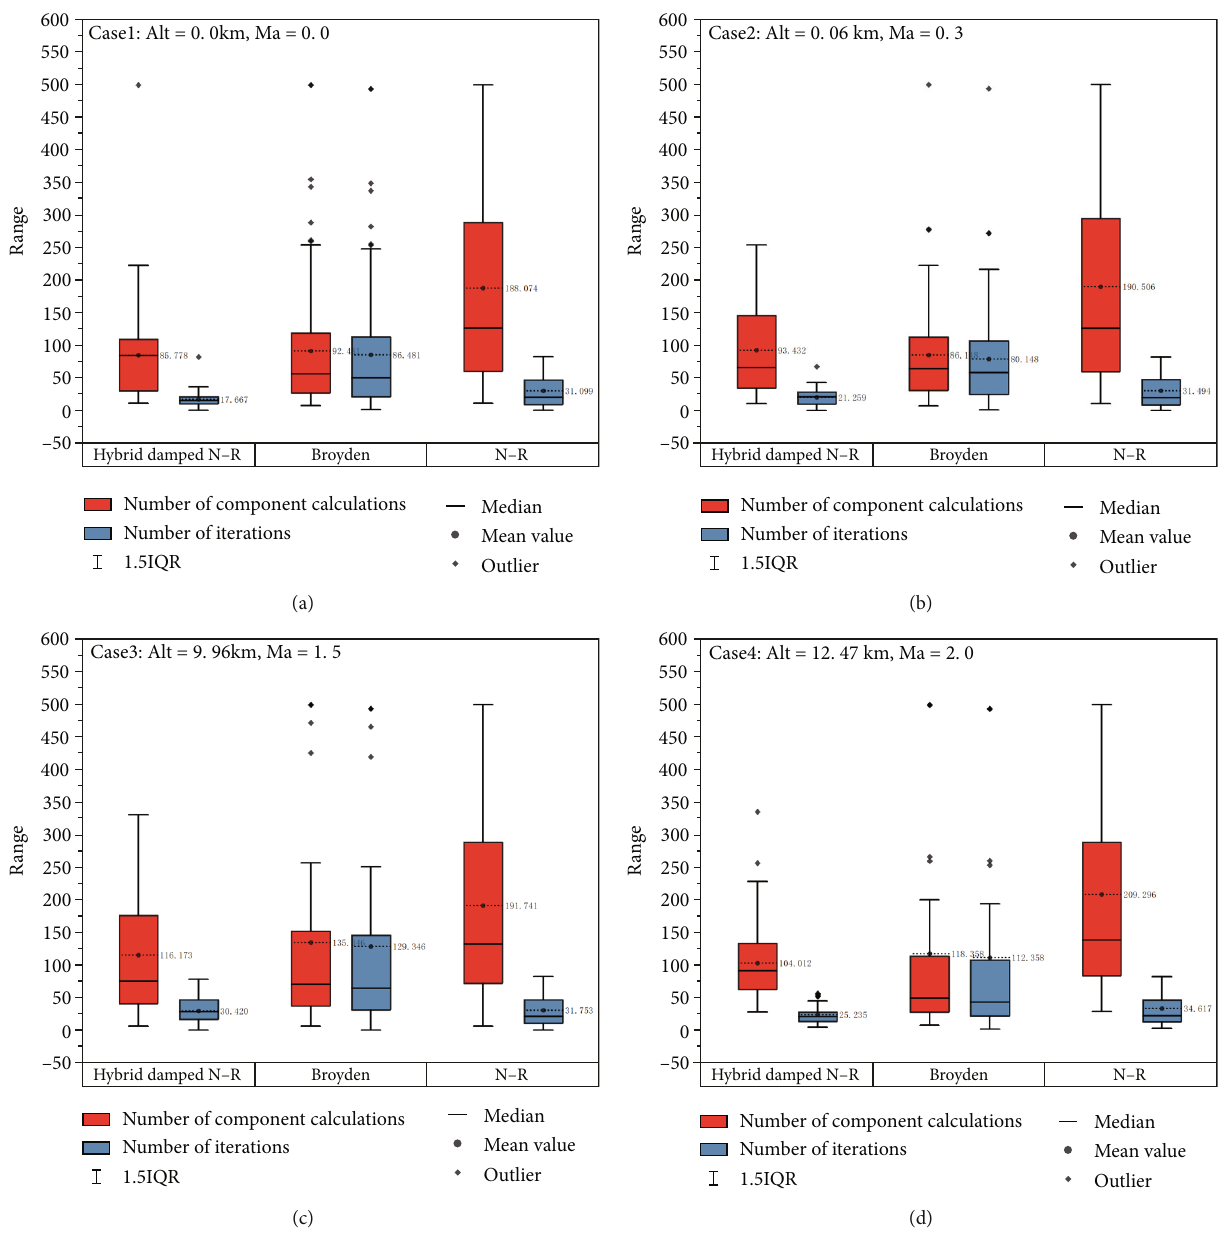
Figure 6: Box plots of the computational speed and iteration e ffi ciency of the three algorithms for di ff erent initial deviation and step size